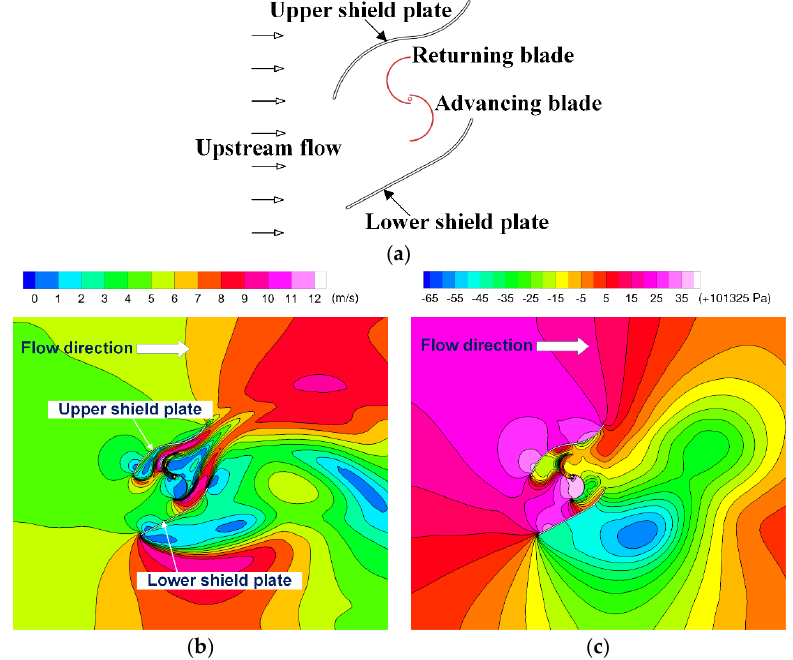
Figure 5. Scheme of curved shield plates. ( a ) Scheme featured by two curved plates [30]; ( b ) Velocity distribution; ( c ) Static pressure distribution.